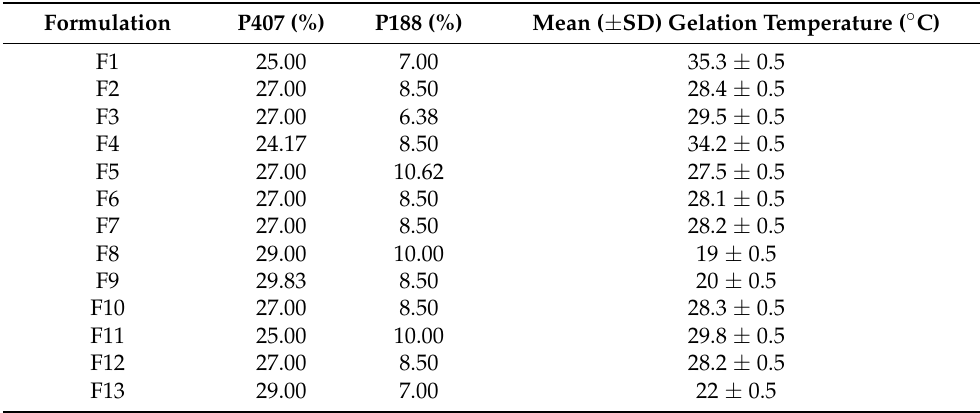
Table 2. Complete design layout corresponding